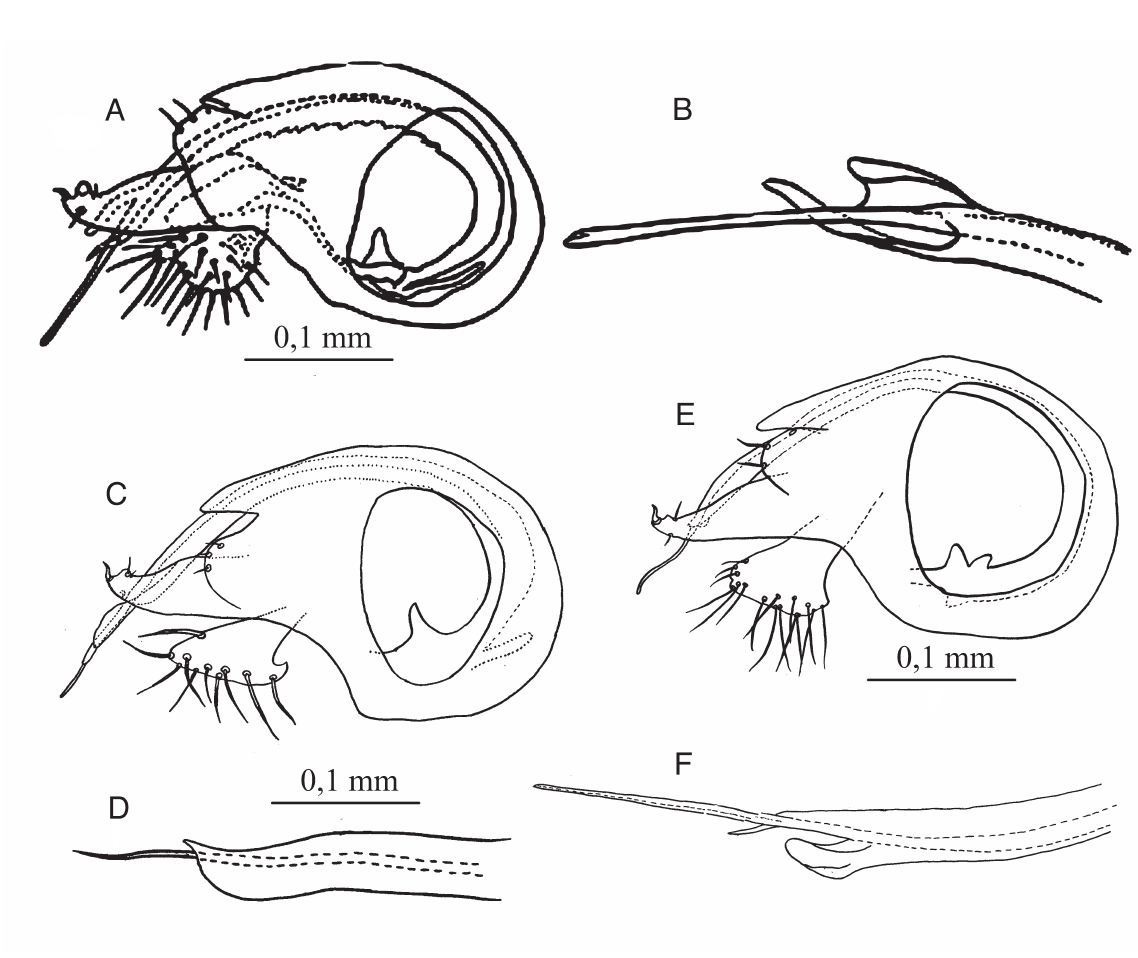
Fig. 4. A – B . Chrysotus tagoi Negrobov, Maslova & Fursov, 2015, ♂, paratype, Japan (Honshu, Ibaraki Pref., Tsukuba), coll. 16. Jul. 1997 by V. Fursov. A . Hypopygium, lateral view. B . Apex of phallus, lateral view. –– C – D . Chrysotus parilis Parent, 1926, Russia (Primorje). C . Hypopygium, lateral view. D . Apex of phallus, lateral view. –– E – F . Chrysotus cilipes Meigen, 1824, Russia (Primorje). E . Hypopygium, lateral view. F . Apex of phallus, lateral